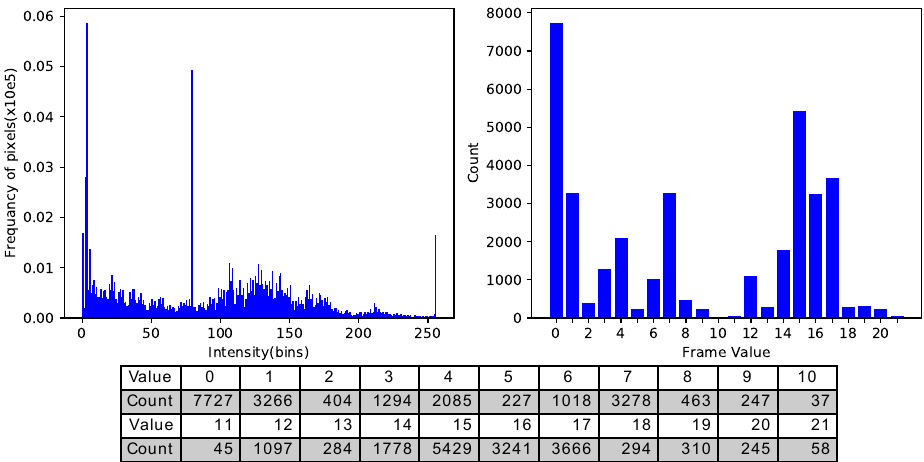
Figure 3. An example of an LBP histogram of an image. From one image, LBP algorithm can detect the angle or corner patterns of the pixels. Then a histogram on the patterns were